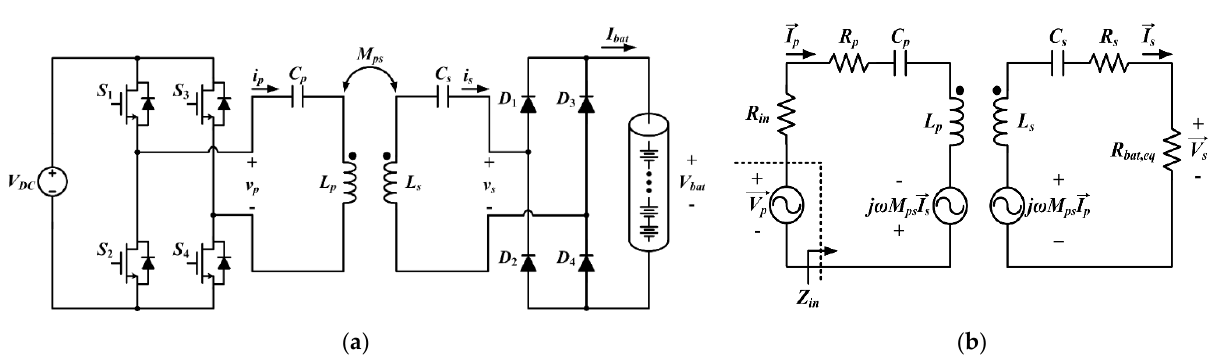
Figure 3. ( a ) Schematic diagram of the proposed single-stage wireless battery charging circuit; ( b ) Equivalent of the proposed circuit.